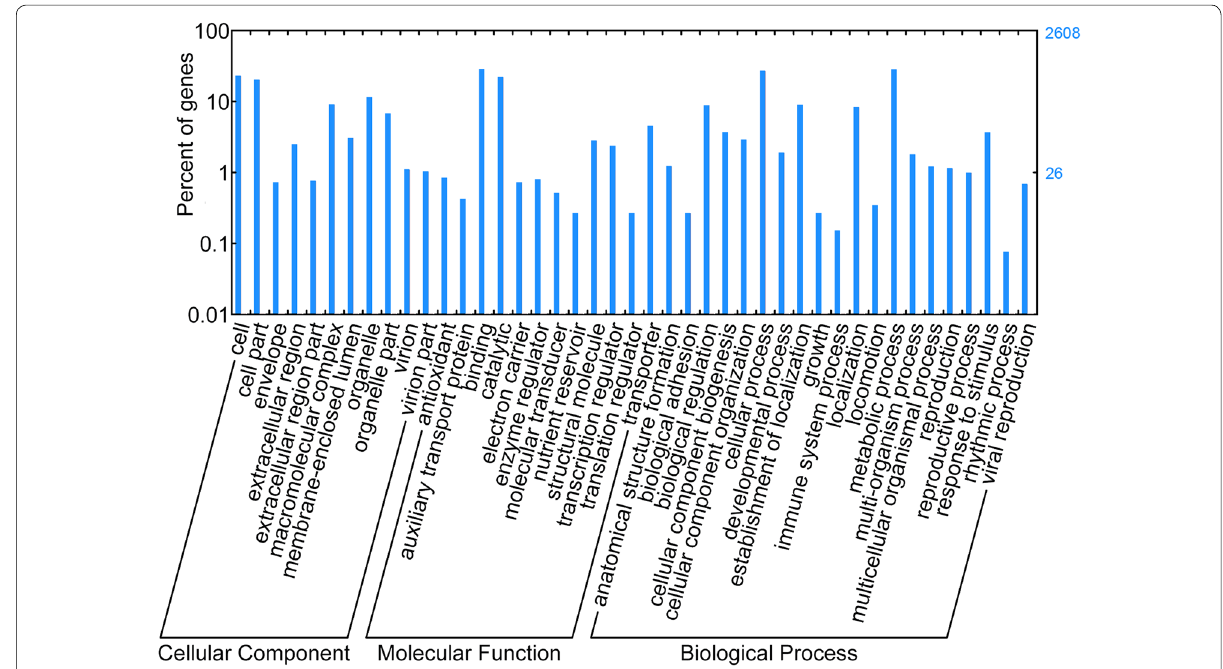
Fig. 3 GO classification of differential expression genes (DEGs) in seeds vs. protocorms